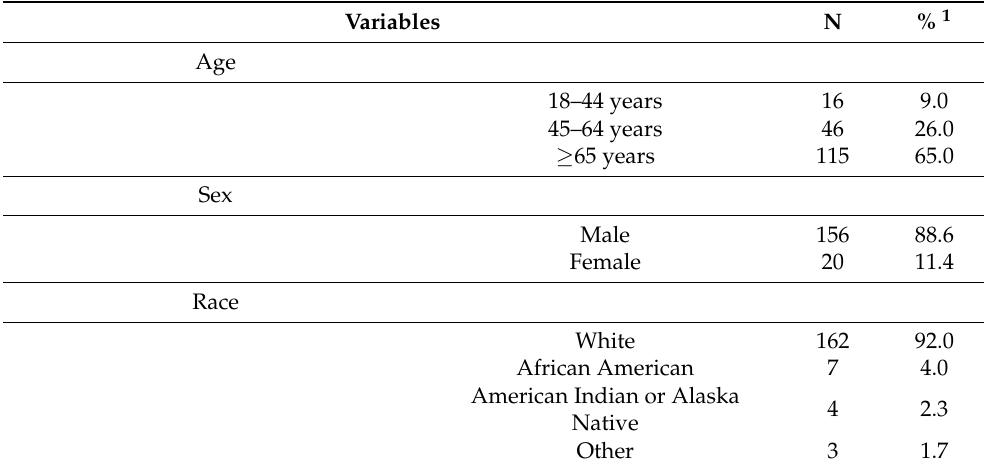
Table 1. Socio-demographics among rural southern Illinois veterans ≥ 18 years recruited from five food pantries from March 2021 to November